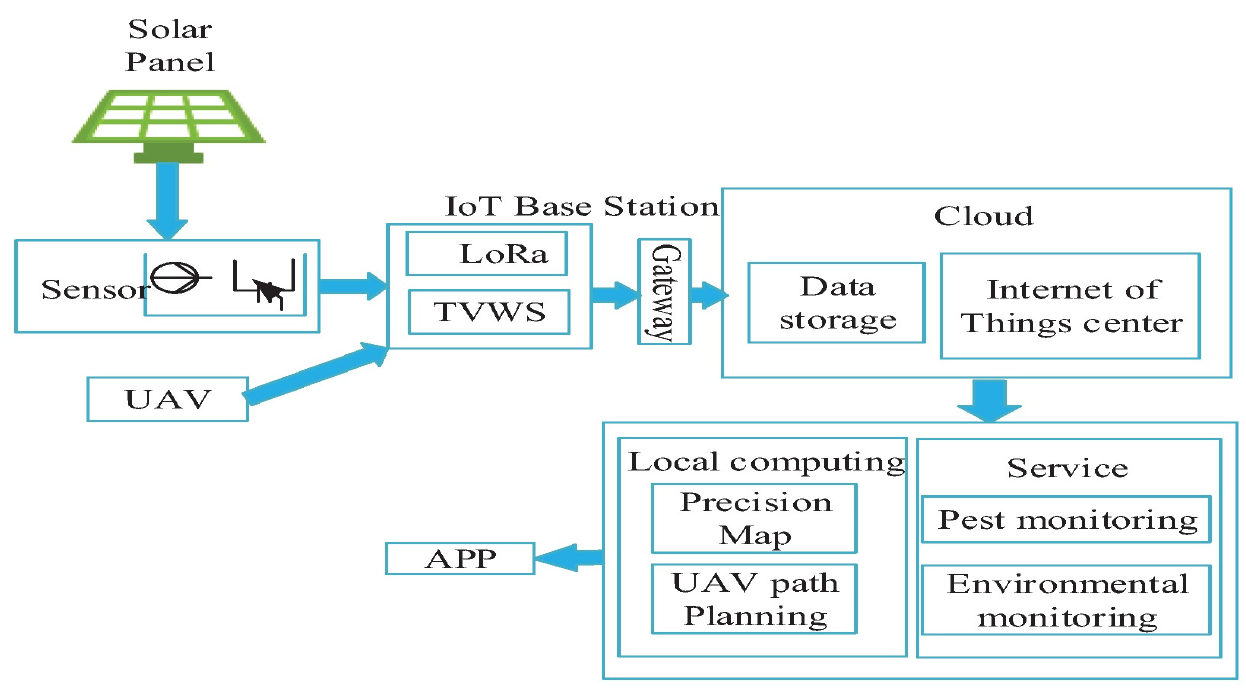
Figure 2. Overview of proposed Agriculture IoT platform [15].